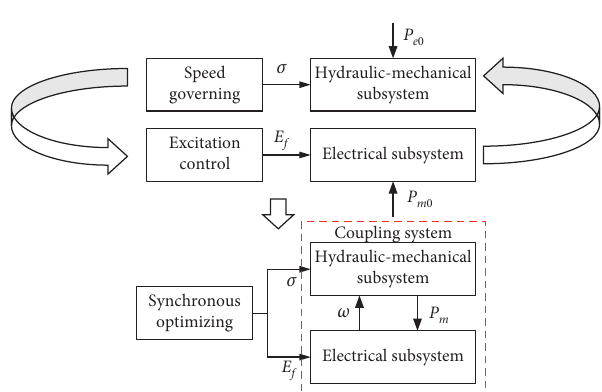
Figure 2: Comparison between conventional and proposed control